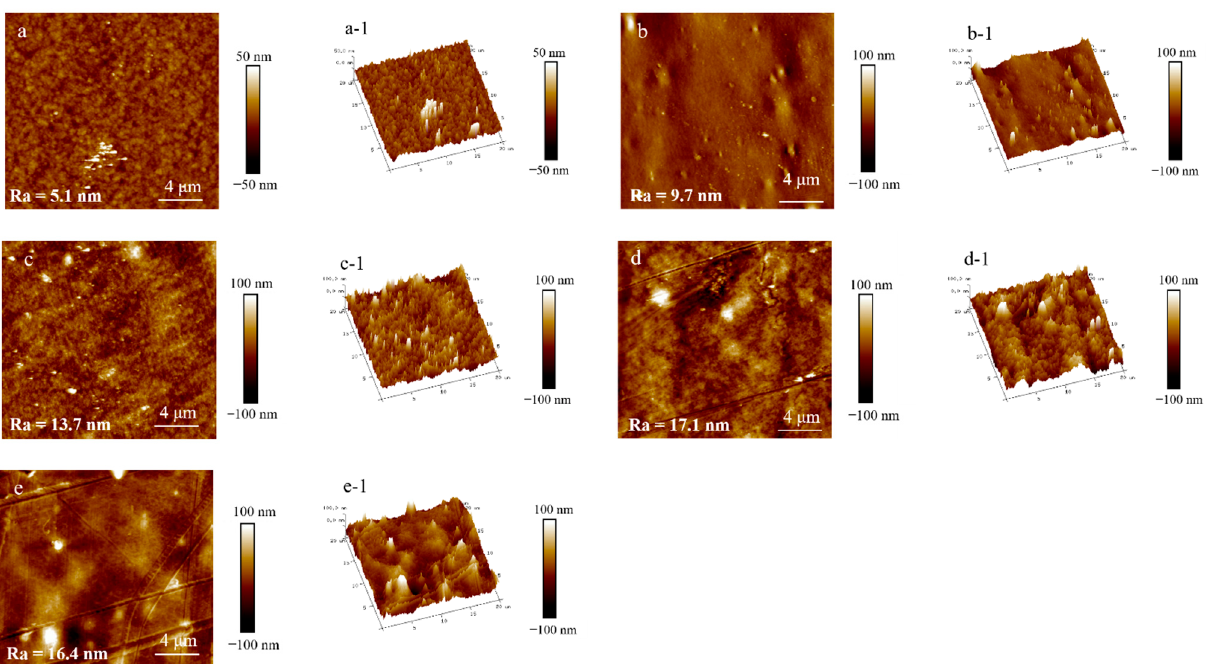
Figure 9. The left picture is the surface textures of PA510/SiO 2 films, and the right picture is the 3D topography of the corresponding film. ( a – e ) are the surface morphology of 1 × 1, 1 × 2, 1 × 3, 2 × 2 and 3 × 3 films, respectively, and the a-1 , b-1 , c-1 , d-1 and e-1 are the corresponding three-dimensional patterns. Ra is the roughness of the surface.